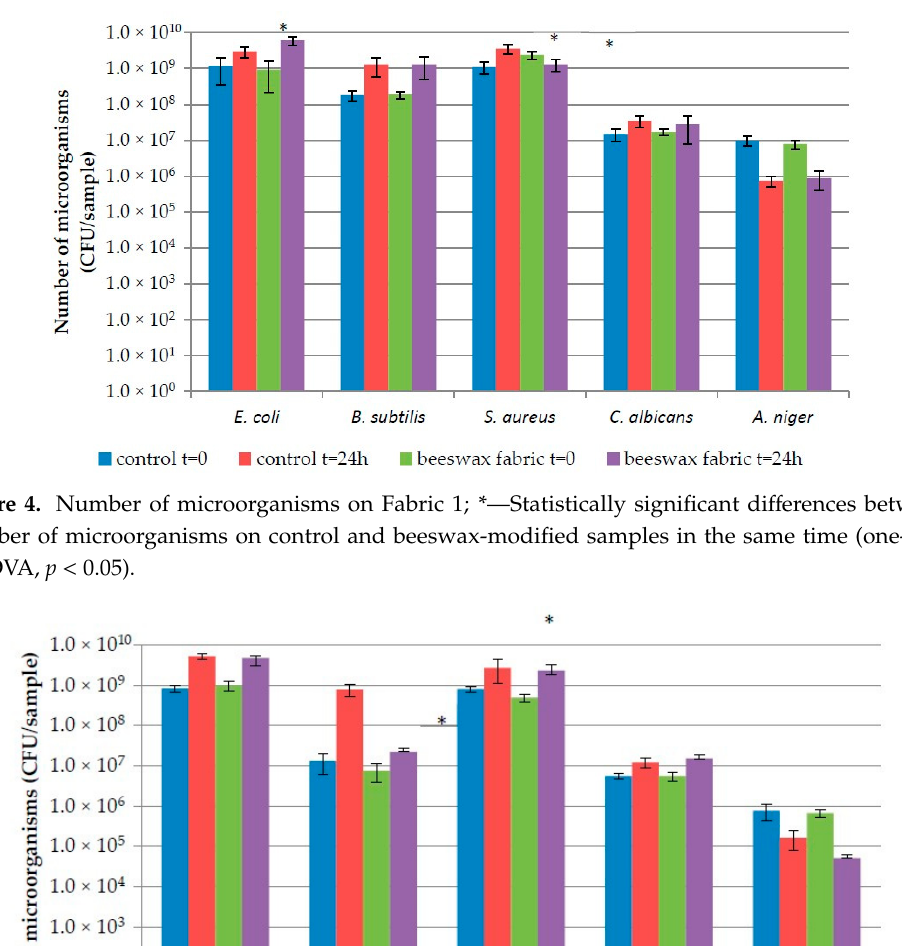
Table 5. Water contact angle (WCA) and hygroscopicity (H) (at different relative air humidity) of fabrics after modification with beeswax.